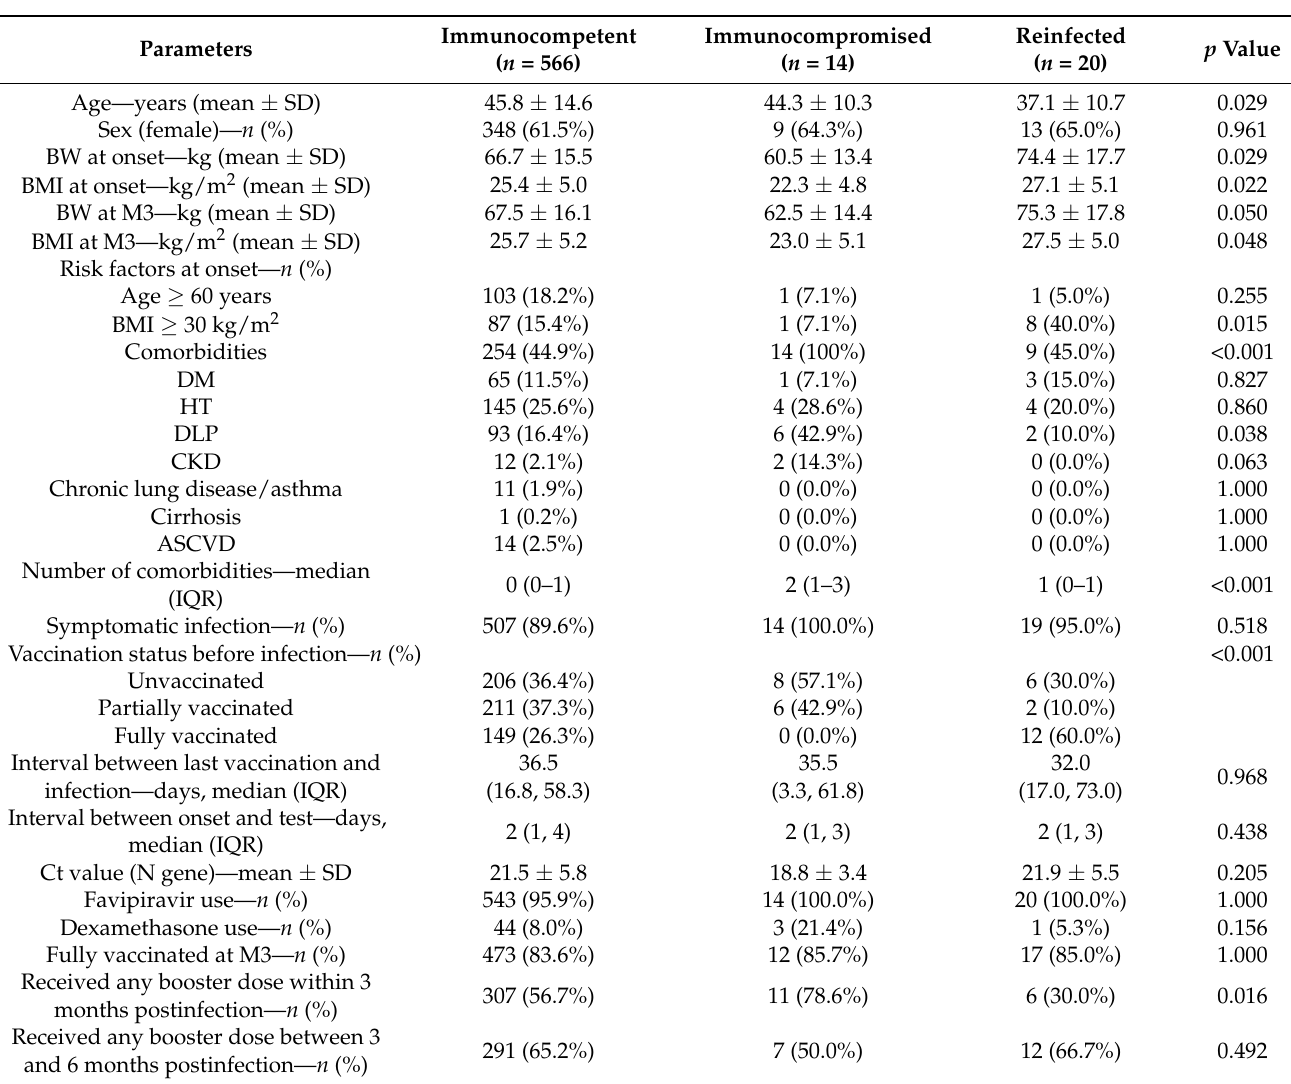
Table 1. Baseline demographic and clinical characteristics of participants; n =